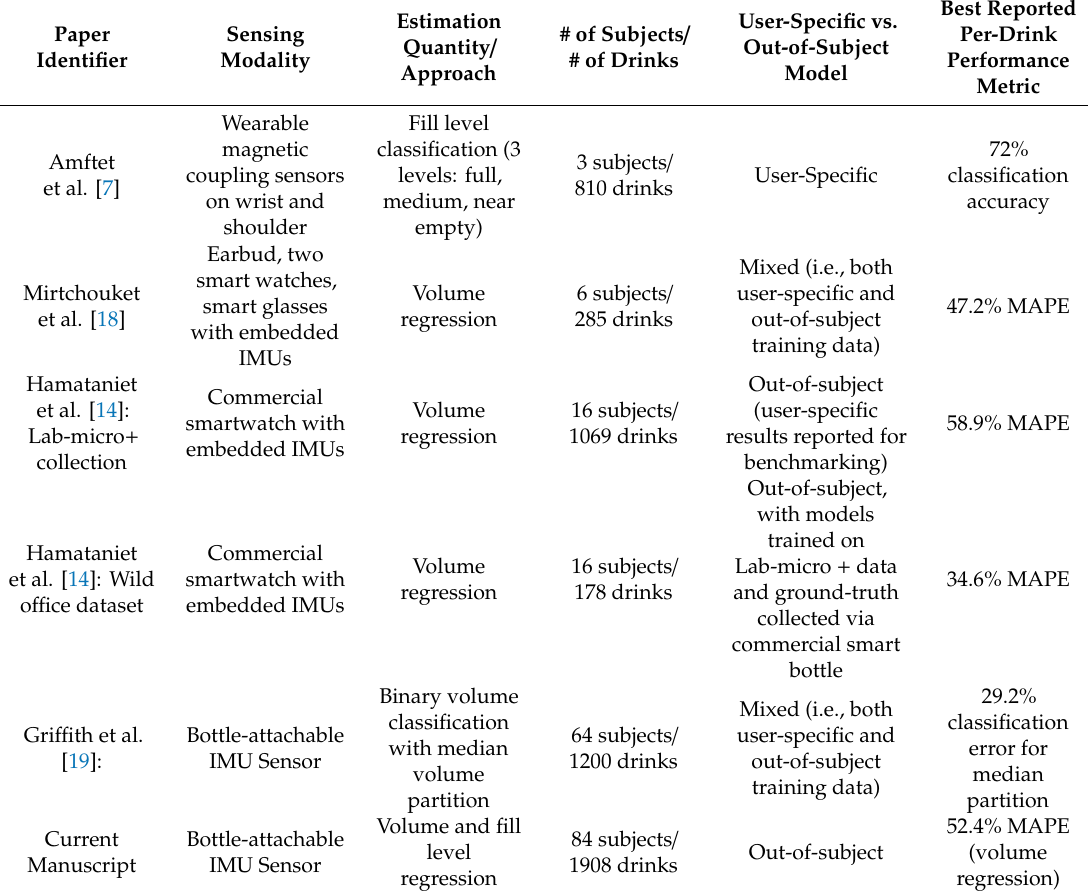
Table 1. Summary of related work reporting volume estimation results on a per-drink